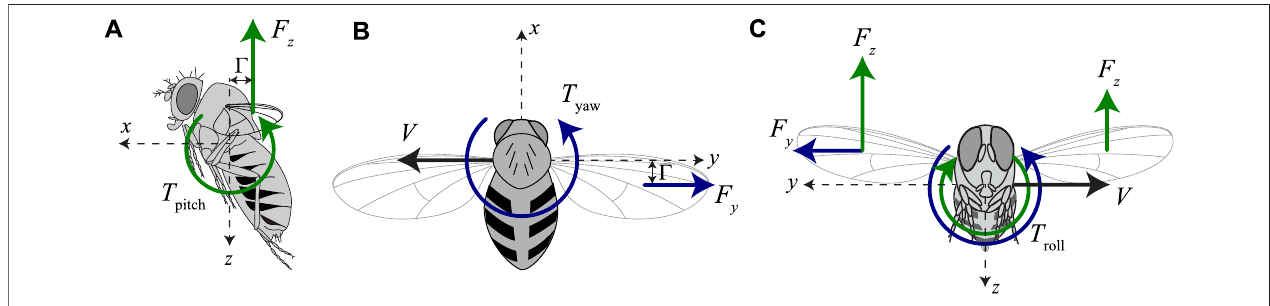
FIGURE4| Ourproposedbodytorquemodelforfruit fl ies fl yingsidewaysatvariablespeedsandwithvariablepitchtorque-producingwing-beatkinematics. (A – C) Free body diagrams of fruit fl ies fl ying sideways, including the pitch, yaw, and roll torque model, respectively. (A) Pitch torque equals the product of the vertical aerodynamic force (| F z |) and the stroke dihedral angle, as proxy for the pitch torque moment arm. (B) Yaw torque equals the product of the sideways aerodynamic drag force ( F y ) and the stroke dihedral angle, as proxy for the yaw torque moment arm. (C) Roll torque depends on both the sideways aerodynamic drag force ( F y ) and the asymmetry in vertical aerodynamic force of the left and right wing ( Δ F z ). These are assumed to scale linear and quadratic with sideways fl ight speed, respectively.